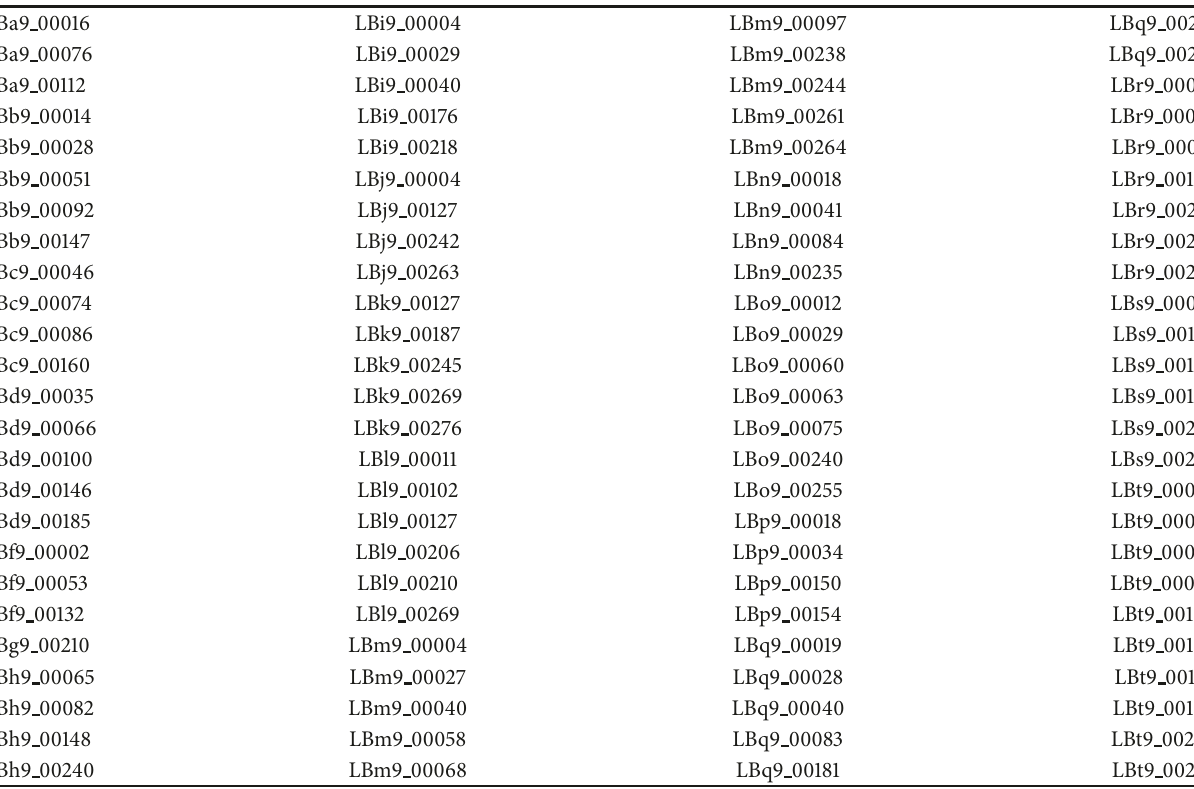
Table 8: BCCWJ title IDs of randomly sampled 100 Japanese